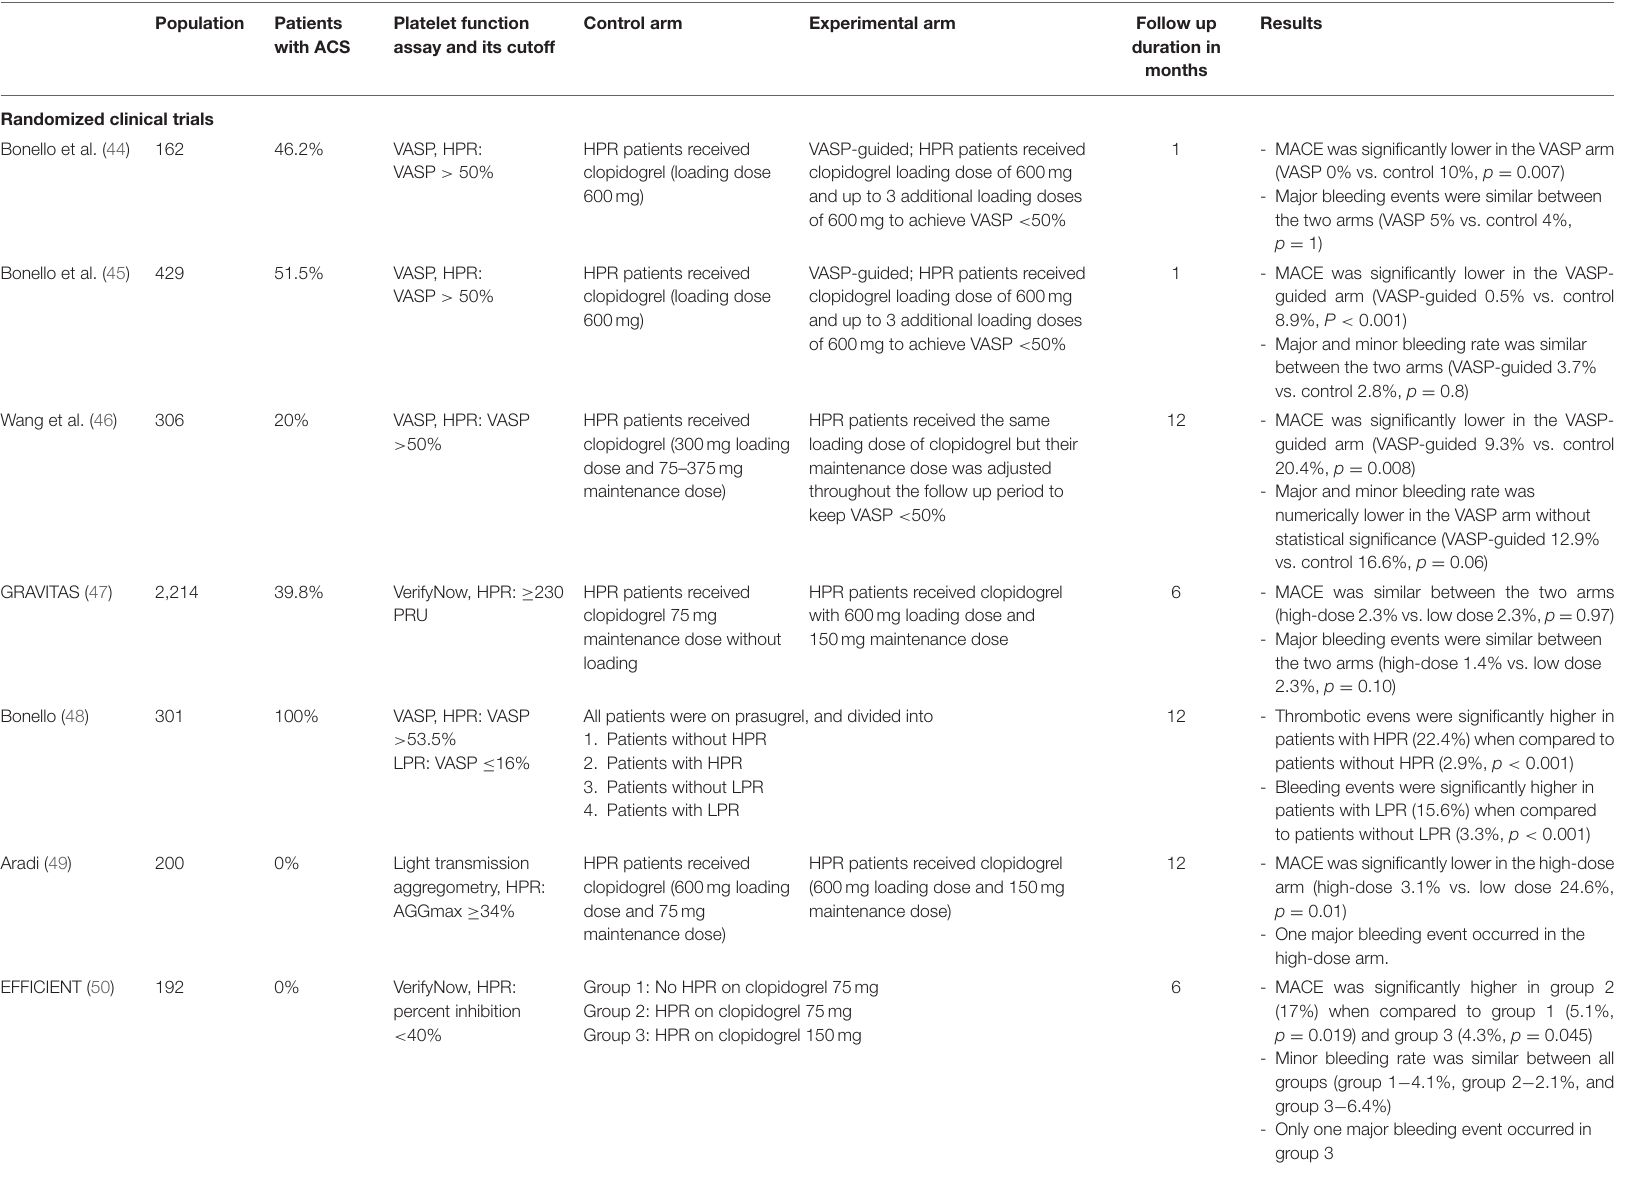
TABLE 2 | Summary of all studies that compared clinical outcomes based on platelet function testing-guided P2Y12 inhibitors. Population Patients Platelet function Control arm Experimental arm Follow up with ACS assay and its cutoff